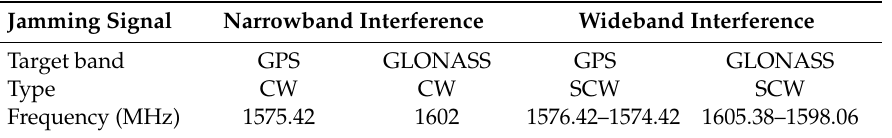
Table 1. Jamming signal specifications.